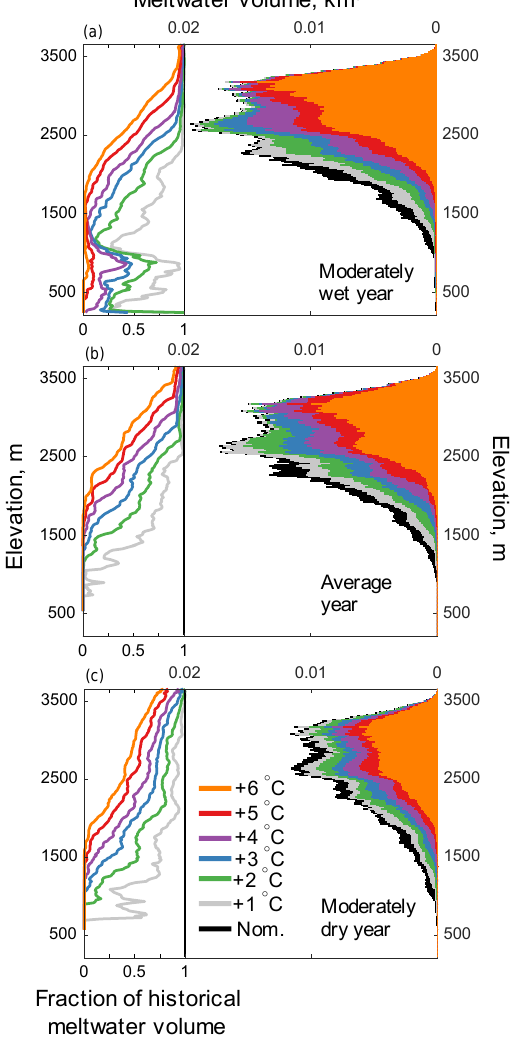
Figure 6. The elevation distribution ( y axes) of simulated annual meltwater volume (right bar graphs) and the fraction of that histor- ical meltwater (line graphs) for each warmer scenario (colors; see legend) for the (a) moderately wet, (b) average, and (c) moderately dry snow seasons. The total meltwater was summed within the same elevation bins used in Fig. 5.